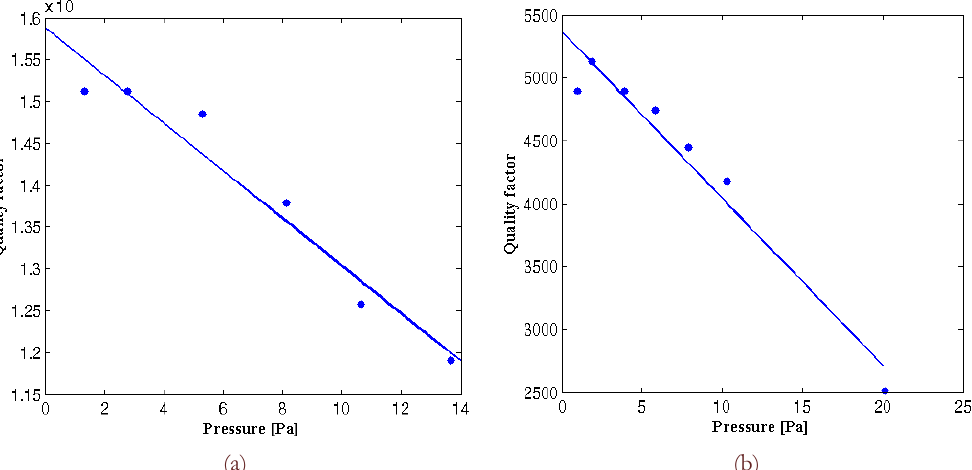
Figure 6: Procedure to determine the quality factor associated to the structural damping for micromirror 1 (a) and 2 (b) reported by Minikes et al